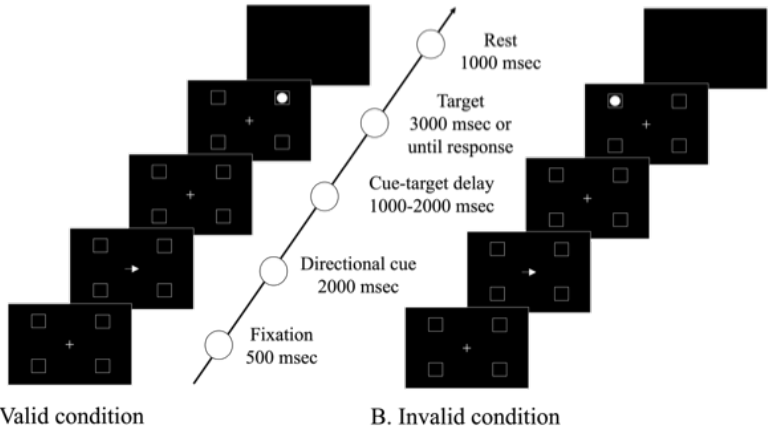
Figure 1. Modified Posner task method. ( A ) valid condition, ( B ) invalid condition. A 17-inch computer display (ROG STRIX GL703VM SCAR Edition, ASUSTeK Com-